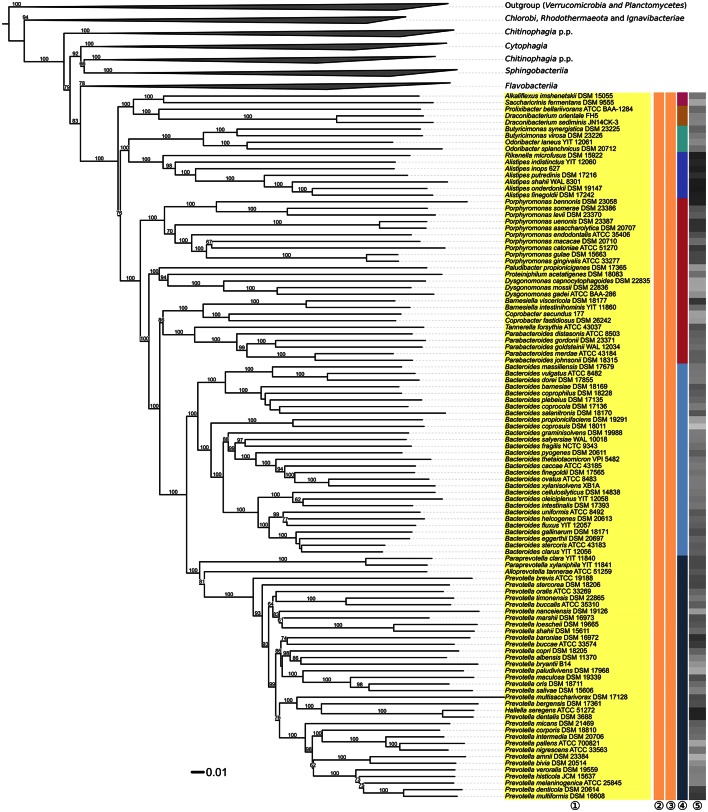
Second part of the phylogenomic tree inferred with GBDP. Tree inferred with FastME from GBDP distances calculated from whole proteomes. The numbers above branches are GBDP pseudo-bootstrap support values from 100 replications. Tip colors indicate the phylum, colors to the right of the ingroup tips indicate, from left to right, class, order and family (see the legend embedded in Figure 2 for details). Gray scale on the very right indicates the exact G+C content as calculated from the genome sequences. The non-Bacteroidia parts of the tree, which have been collapsed here, are shown in Figures 2, 4.